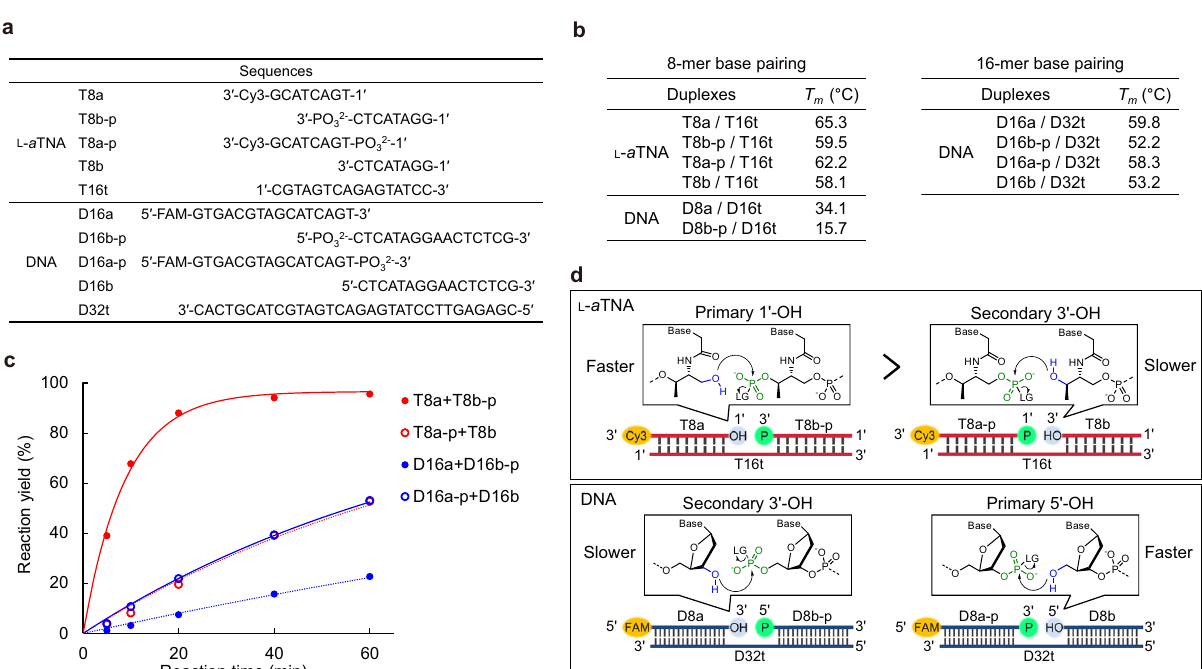
Fig. 2 Evaluation of rate of chemical ligation. a Sequences of 8-mer fragments and 16-mer template of L - a TNA and 16-mer fragments and 32-mer template of DNA. b Melting temperatures of fragment/template duplexes. c Yield as a function of time for the chemical ligation reactions of L - a TNA (red circles) and of DNA (black circles) with either primary (closed circles) or secondary OH termini (open circles). Conditions: [oligomers] = 1.0 μ M each, [NaCl] = 100 mM, [MnCl 2 ] = 20 mM, [CNIm] = 20 mM, 25 °C. Source data are provided as a Source Data fi le. d Schematic illustration of chemical ligation focusing on condensation between OH and